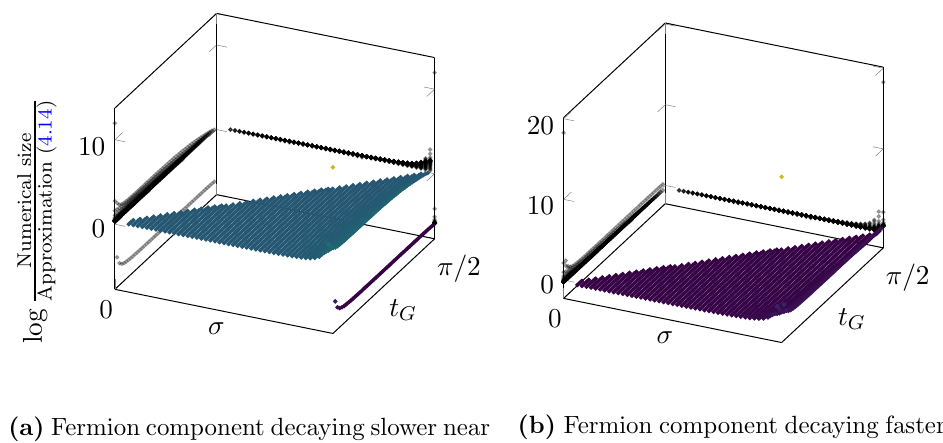
Figure 7. Comparison of the approximation (4.14) and numerical results for q = 1000 and (cid:12)